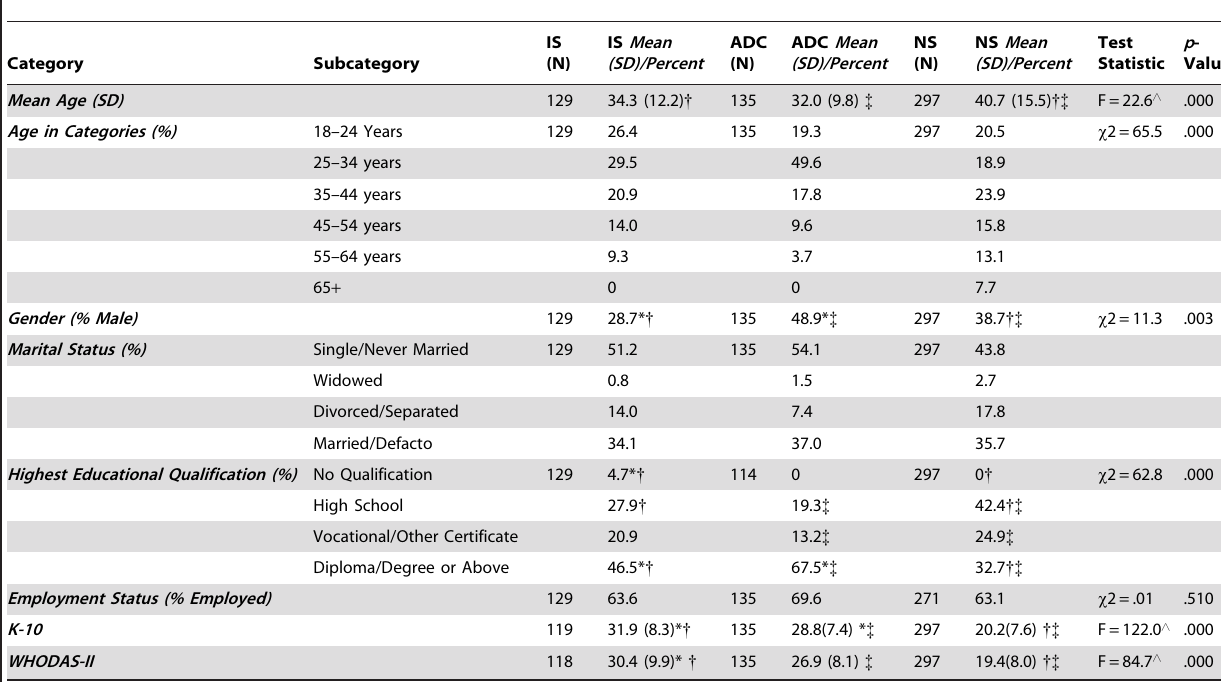
Table 1. Comparisons of demographic data and severity of symptoms for the Internet Survey, Anxiety Disorders Clinic and National Survey groups.